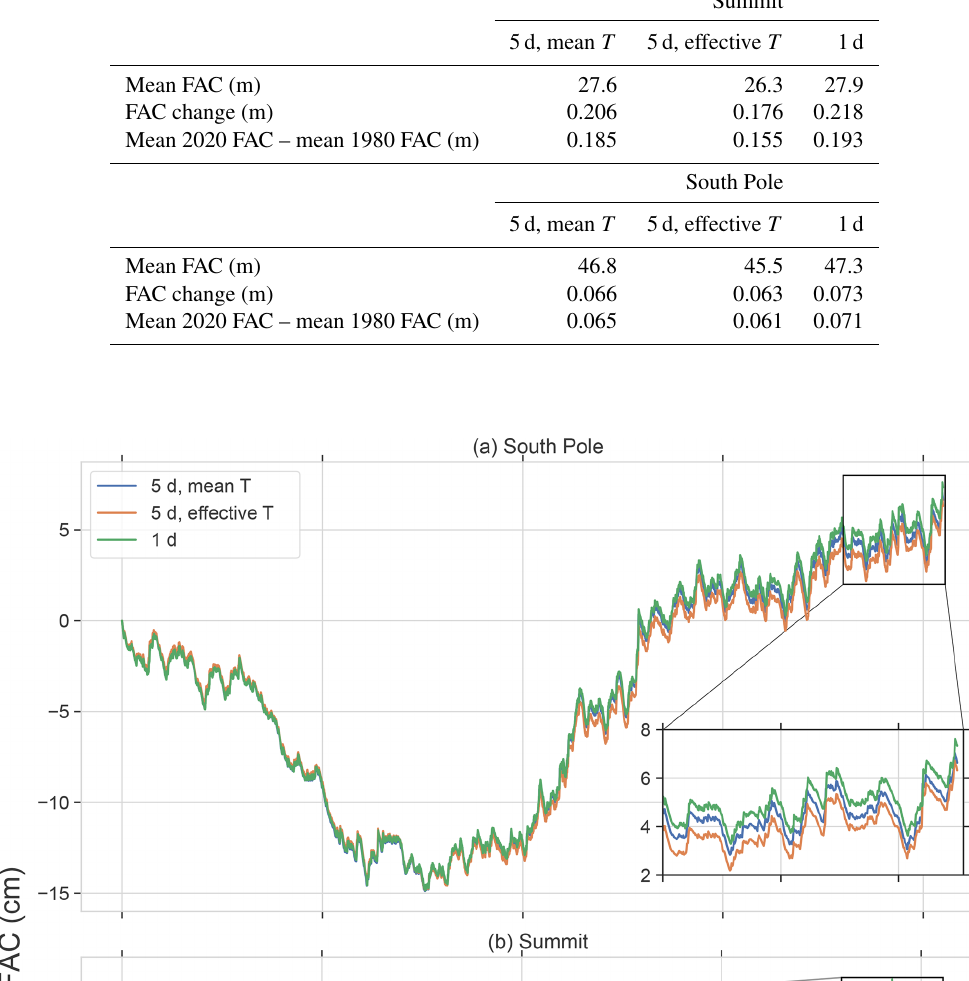
The Cryosphere, 16, 3971–4011,